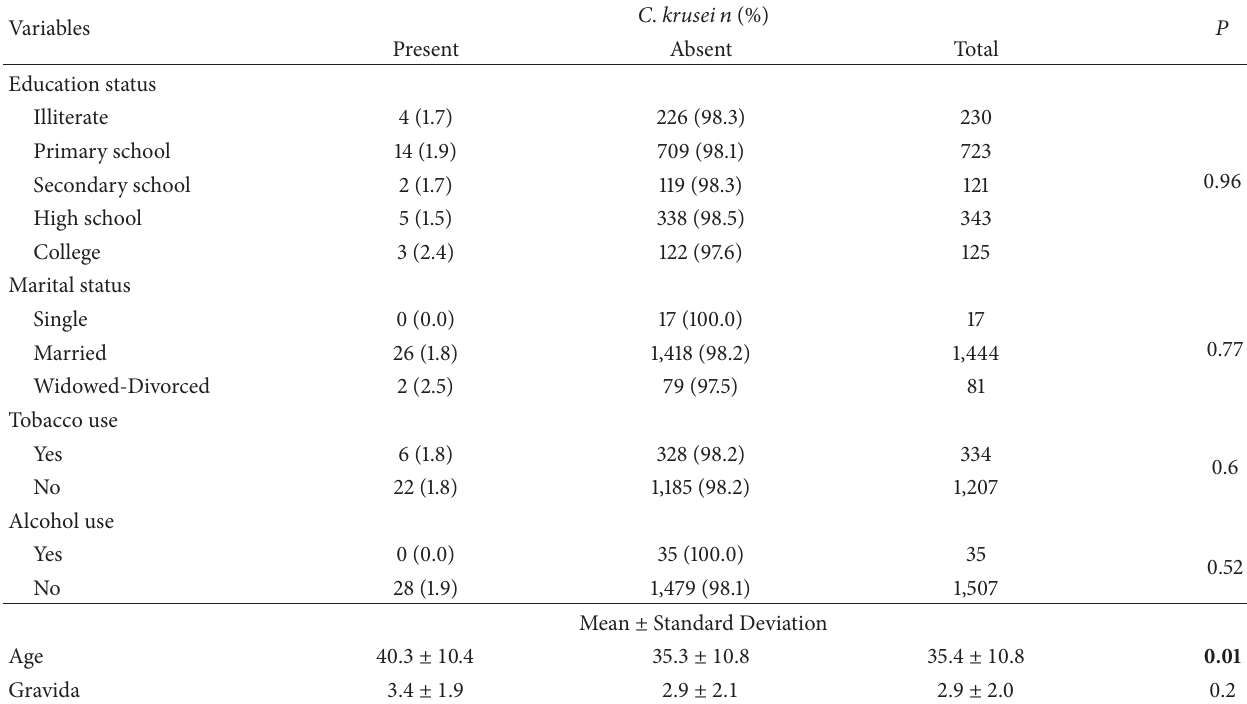
Table 1: Basic demographic characteristics of women with vaginal complaints in this